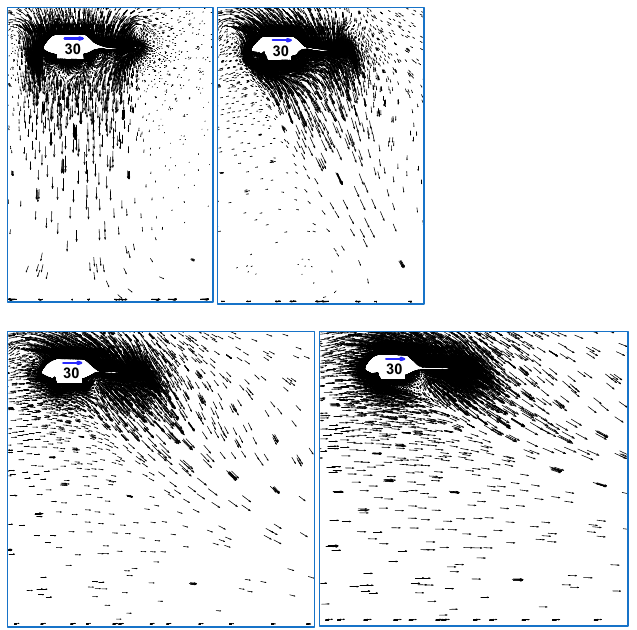
Figure 22. Distribution of wake flow when the helicopter tank bottom was 20 m above the ground (wind speed was 0 m/s, 5 m/s, 10 m/s, and 15 m/s; reference speed marked on the fuselage, indicated by a blue arrow, and the reference speed is 30